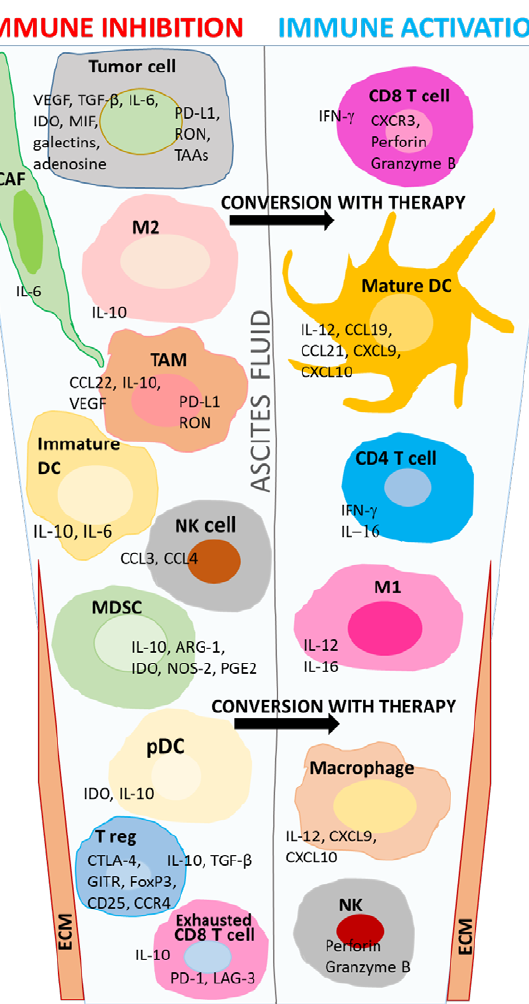
Figure 1. Schematic representation of the primary immune components in the tumor microenvironment (TME) . Several cell types in the TME of high-grade serous ovarian carcinoma (HGSOC) elaborate factors that can lead to immune dysregulation and inhibition of antitumor responses. The ascites of these patients is rich in TGF-β, IL-6, IL-8, IL-10, vascular endothelial growth factor (VEGF), and CCL22 and other factors released by contributing cell types as shown in the graphic. CCL22 (the ligand for CCR4) preferentially recruits Tregs into tumors. Exhausted CD8 T cells in tumors express PD-1 and LAG-3 and secrete low quantities of IFN-γ. Several Treg subsets exist in the TME, each bearing some of the phenotypic markers, CD4, CD8, CCR4, FoxP3, CD25, GITR, or CTLA-4, and primarily release TGF-β and IL-10. Molecules such as recepteur d’origine nantais (RON) on tumor cells are associated with invasiveness, and tumor associated antigens (TAAs) such as New York Esophageal antigen-1 (NY-ESO-1), human epidermal growth factor receptor 2 (HER-2), and Wilm’s tumor-1 (WT-1) are immunogenic targets. Immune-suppressive mechanisms in the TME that foster tumor initiation, progression, and recurrence may be reversed with combinations of conventional and novel therapies, designed to potentiate antitumor immune responses. Parameters consistent with disease improvement include CD8+ T cells secreting IFN- γ , perforin, and granzyme B, which facilitate the killing of tumor cells. Additionally, DC-secreted chemokines, such as CXCL9 and CXCL10, can recruit CD4+ and CD8+ immunocompetent T cells, and IL-16-a-cytokine secreted by T cells, macrophages, and dendritic cells, is a primary chemoattractant for CD4+T cells in ovarian